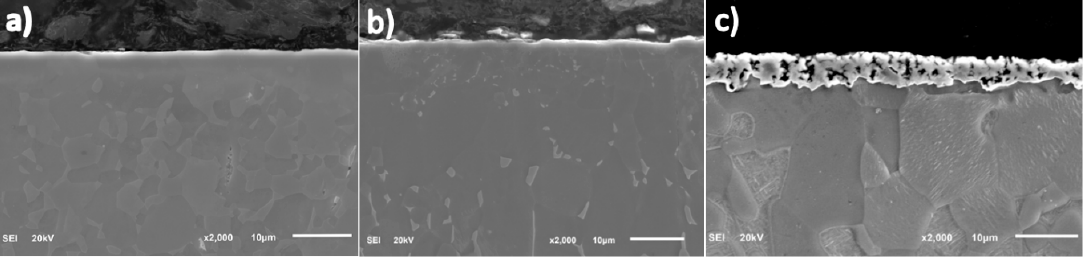
Figure 3. SEM images of the microstructure of the Ti6Al4V alloys after: ( a ) nitriding ( b ) oxidation ( c ) carburizing.